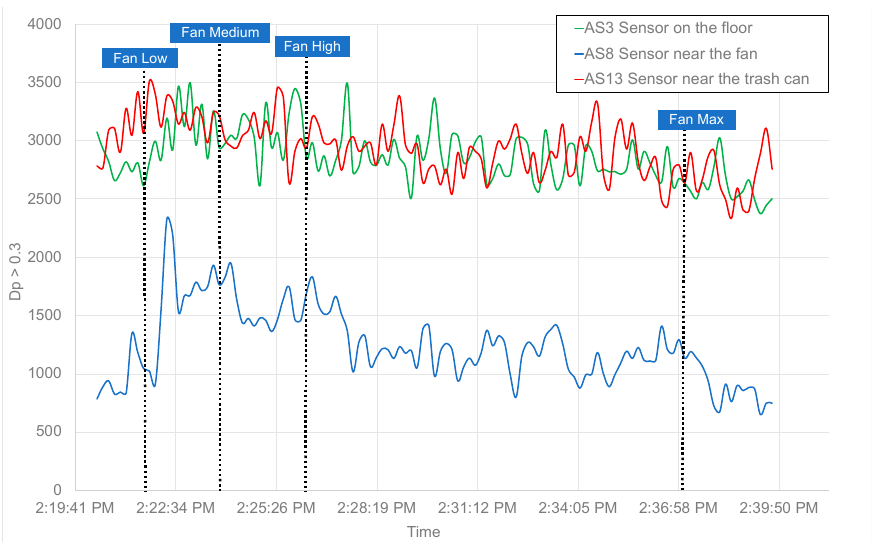
Figure 7. The number of particulates larger than PM 0.3 (Dp > 0.3) data from three sensors AS3, AS8, and AS13 used to evaluate the effectiveness of the Surgically Clean Air Jade HEPA air puri- fier is presented. The data show a minimal change in particulate count regardless of the fan speed. After further investigation, it was discovered that the HEPA filter was not sealed properly, which caused the particles to escape and get circulated by the fan.